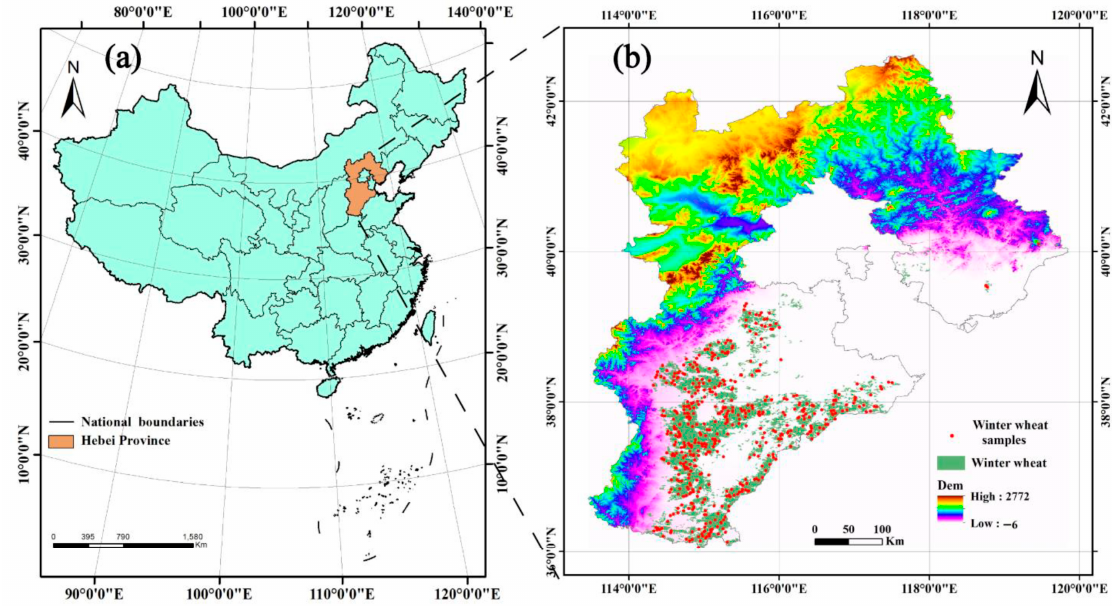
Figure 1. ( a ) Location of the study area. ( b ) Winter wheat distribution (green) and winter wheat samples used to predict NDVI (red).